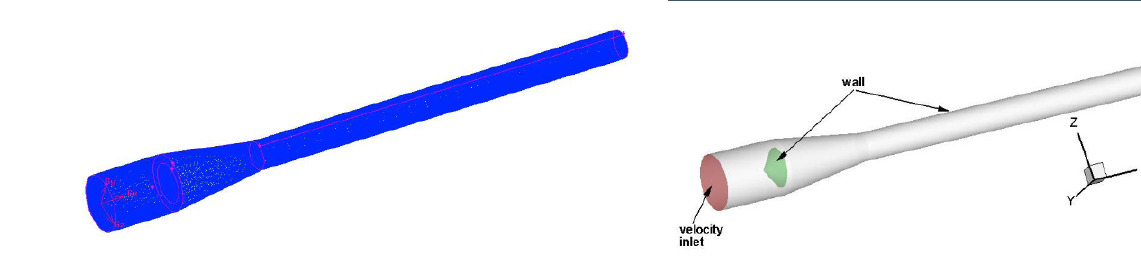
Figure 2. Computational domain with boundary conditions for com- bustion chamber.